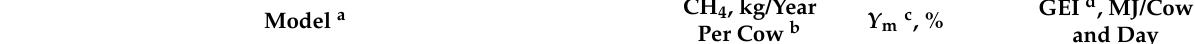
CH 4 , kg/Year GEI d , MJ/Cow Y m c , % Per Cow b and Day 6000 kg ECM and 38.0% concentrate